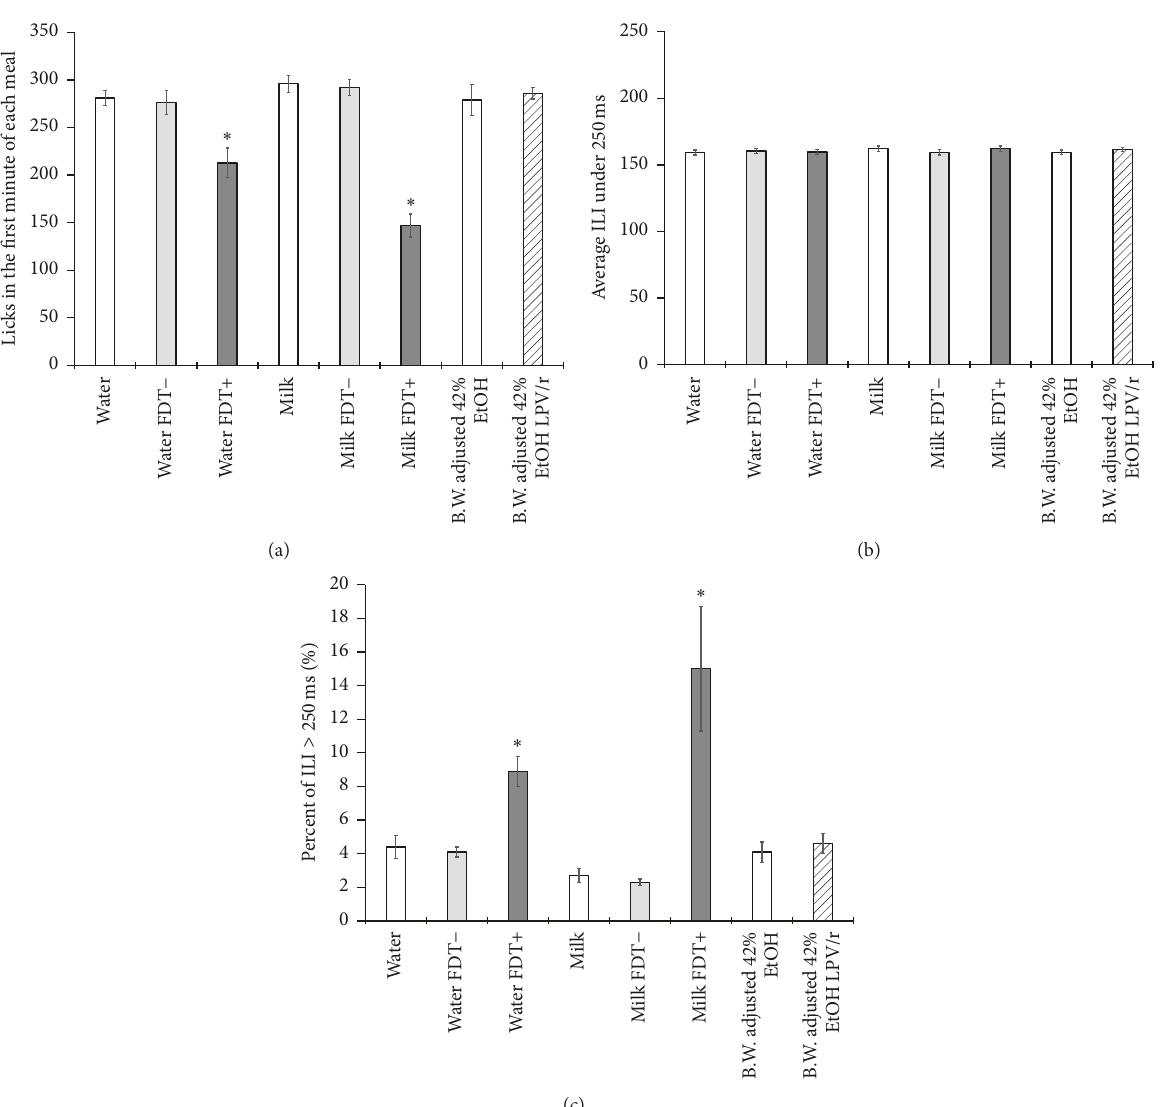
Figure 6: Analyses of intrameal licking patterns associated with palatability with bars representing means and SEM error bars. (a) Licks in the first 60 s of each meal. Stars represent significant ( 𝑝 < .01 ) decreases in licking to the FDT+ solutions. (b) The average interlick interval (ILI) when less than 250 ms. (c) The percentage of interlick intervals in the range of 250–1,000 ms with stars representing significant ( 𝑝 < .01 ) increases in longer ILI for